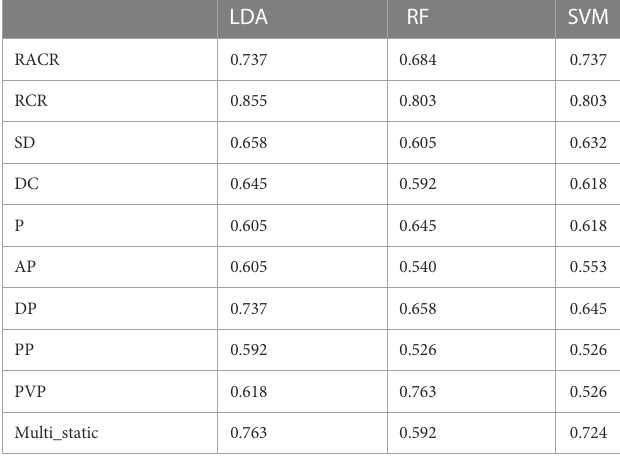
TABLE 4 Prediction accuracies based on various dimensions of LDA, RF and